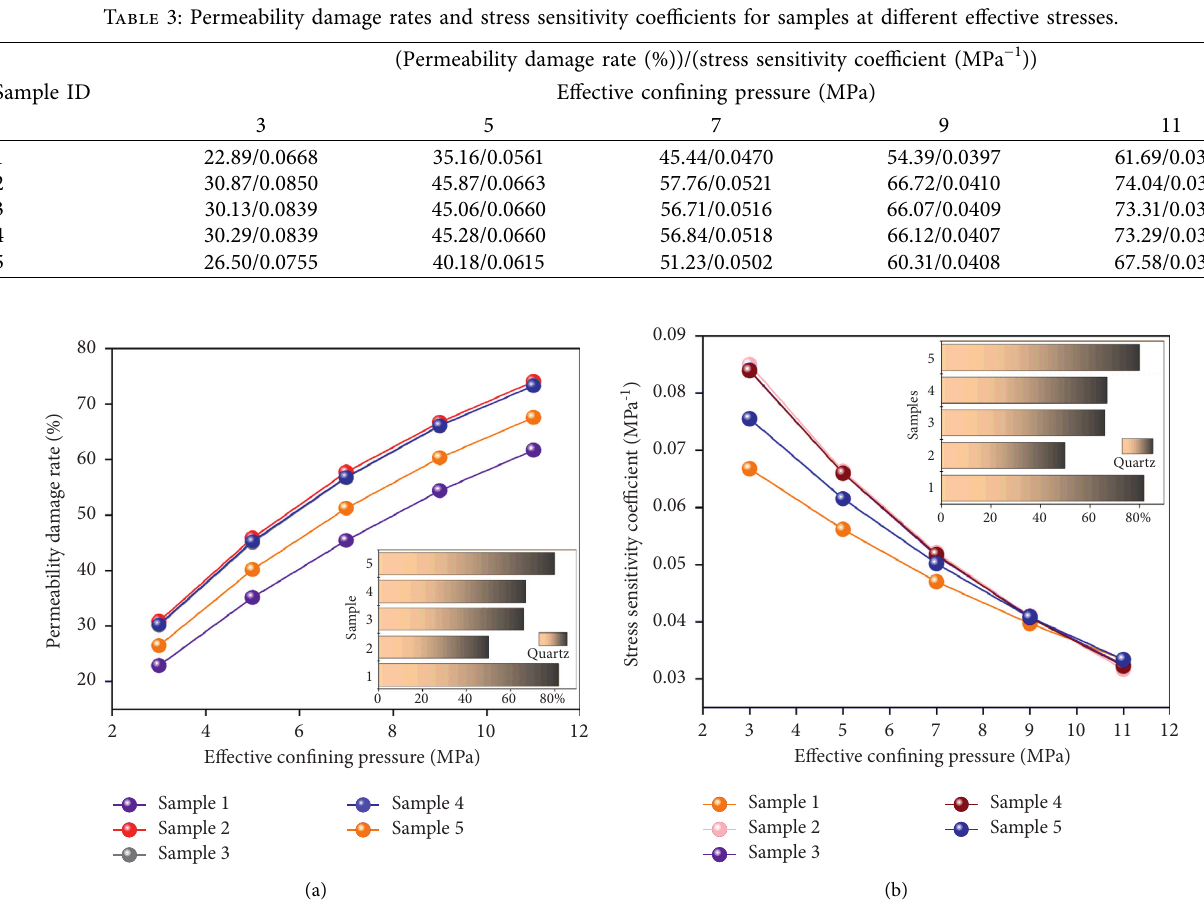
Figure 6: Relationship between quartz content and permeability damage rate and stress sensitivity